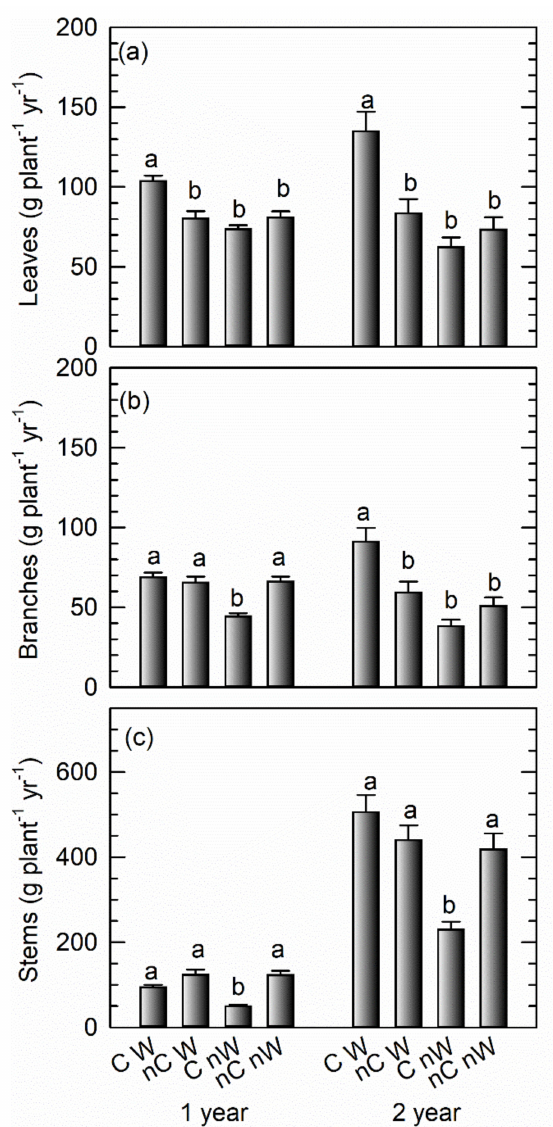
Figure 3. Annual biomass increments of ( a ) leaves, ( b ) branches, and ( c ) stems of Salix sachalinensis in the first and second growing seasons after cutback. C and nC represent with and without cutback; W and nW represent with and without weed control, respectively. The significance values of the factorial analysis are shown in Table S2. Di ff erent letters indicate significant di ff erences in the corresponding values in a single year at p < 0.05. Values shown are mean ± SE from two clones of the same species. Cutback promoted the formation of multiple stems (Figure 4, Table S1). Interestingly, a significant interaction between cutback and weed control was observed with respect to the number of stems per cutting, indicating that weed control is important for cutback to enhance